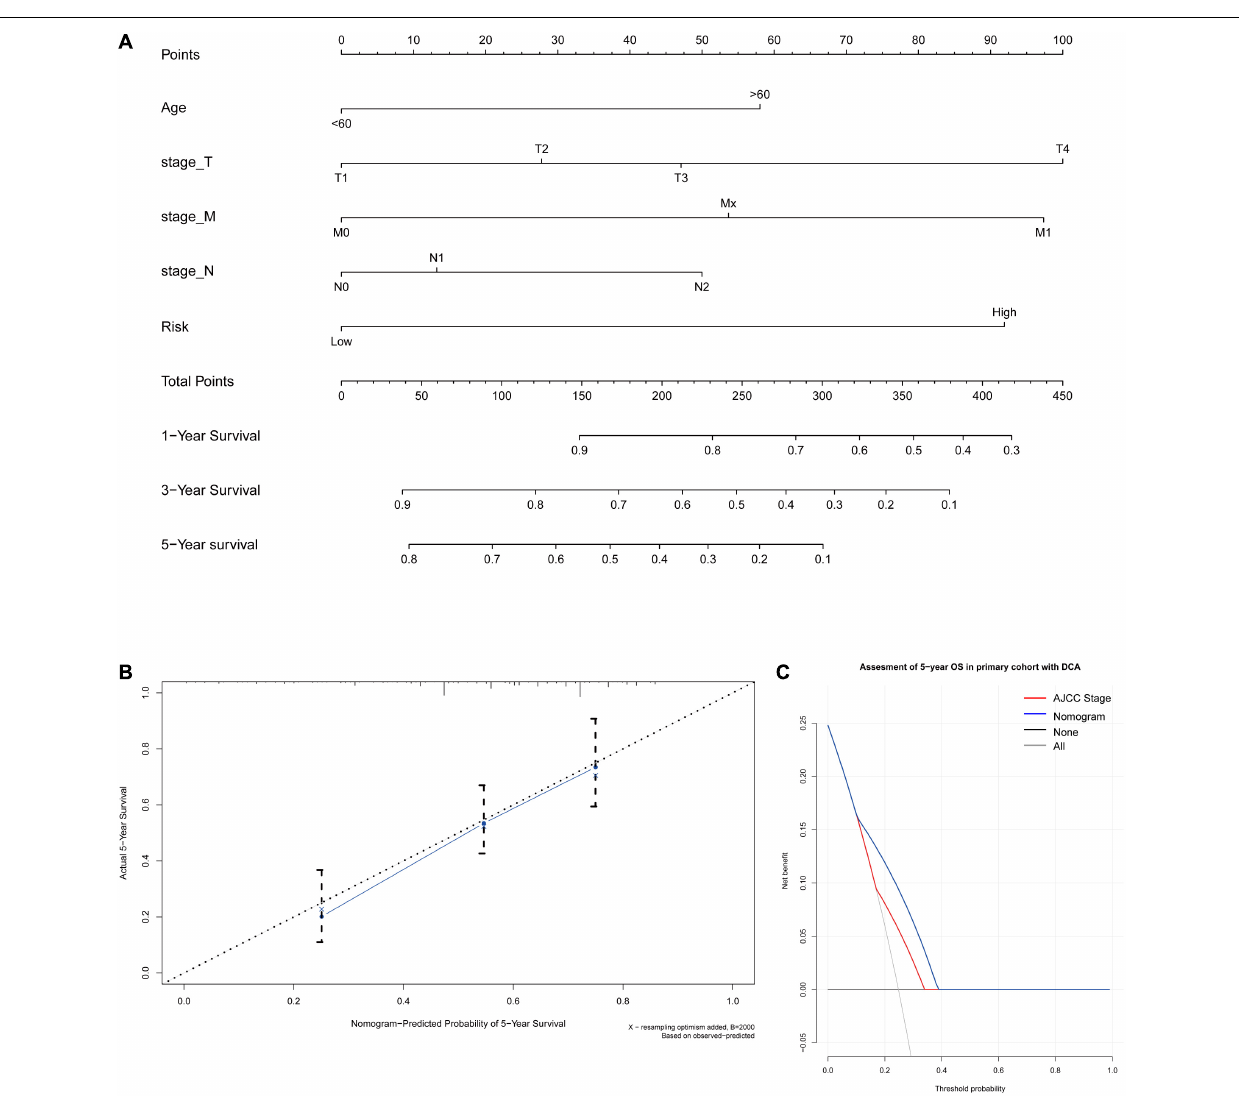
FIGURE 7 | (A) A nomogram for predicting 1-, 3-, and 5-year OS in colon cancer. To calculate probability of OS, first determine the value for each factor by drawing a vertical line from that factor to the points scale. “Points” is a scoring scale for each factor, and “total points” is a scale for total score. Then, sum all of the individual values and draw a vertical line from the total points scale to the 1-, 3-, and 5-year OS probability lines to obtain OS estimates. (B) Calibration curves for the probability of OS at 5 years. The nomogram cohort was divided into three equal groups for validation. The gray line represents the perfect match between the actual ( y -axis) and nomogram-predicted ( x -axis) survival probabilities. Black circles represent nomogram-predicted probabilities for each group, and X’s represent the bootstrap-corrected estimates. Error bars represent the 95% CIs of these estimates. A closer distance between two curves suggests higher accuracy. (C) The DCA of nomogram in the training set for 5-year